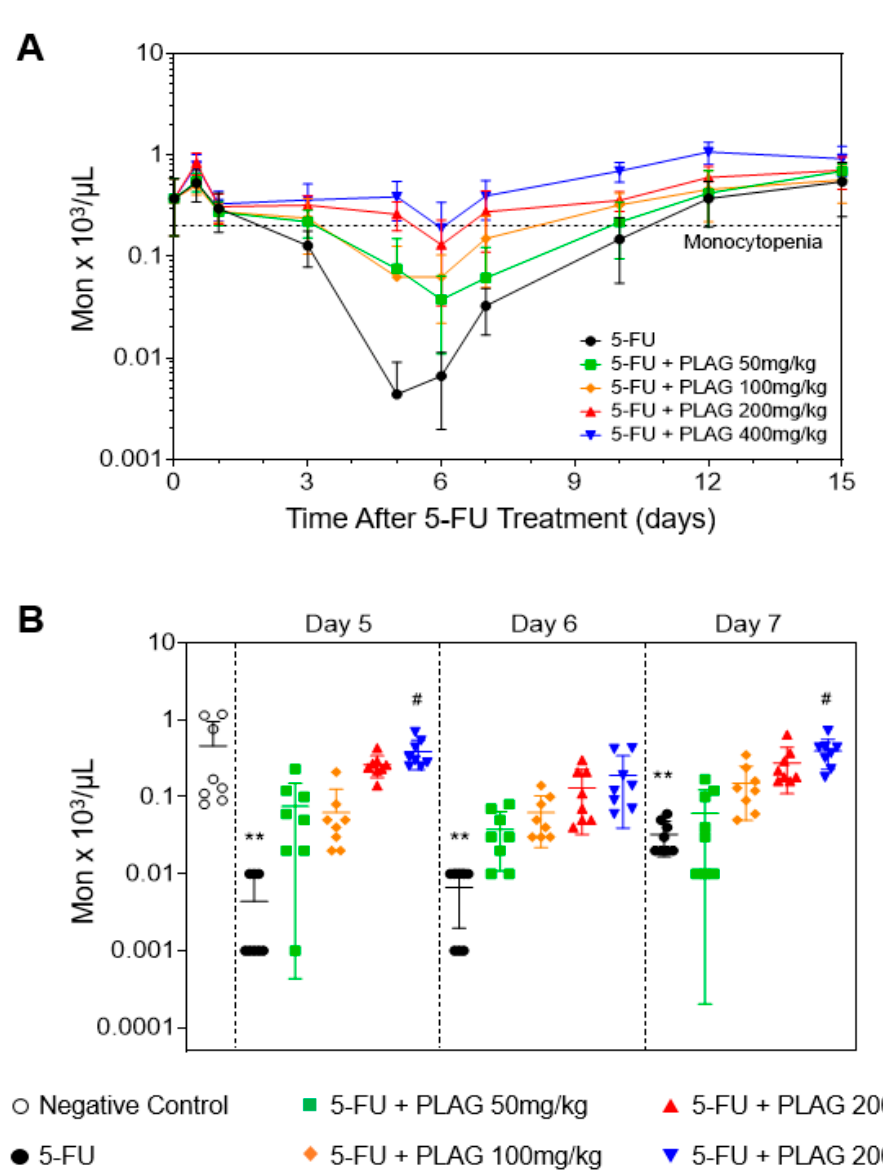
Figure 2. PLAG mitigates 5-FU-induced monocytopenia. Mice ( n = 8 males per group) were intraperitoneally injected to 100 mg/kg of 5-FU immediately followed by oral administration of 50, 100, 200, and 400 mg/kg of PLAG, continuing daily until day 15. ( A ) Effect of PLAG administration on the kinetics of peripheral monocytes after 5-FU injection for 15 days. ( B ) The peripheral monocyte counts are presented as dots on days 5, 6, and 7. The complete blood counts (CBCs) data are representative of five independent experiments with eight mice per group. * indicates negative control vs. 5-FU, and # indicates 5-FU vs. 5-FU + PLAG-treated groups. */# p < 0.05, **/## p < 0.01, ***/### p < 0.001. ns., not significant.